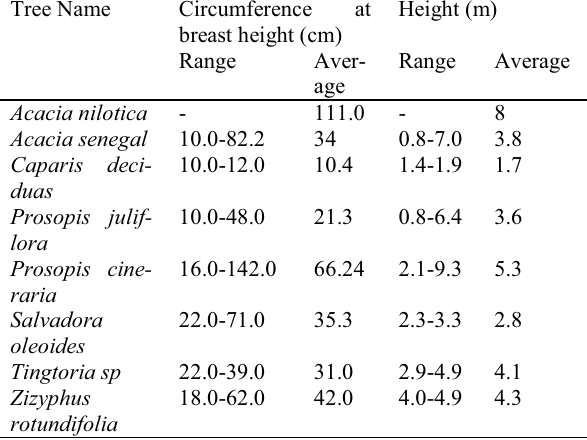
Table 2. Circumferences at breast height (CBH) and height of trees at Jaisalmer region of the Indian Thar